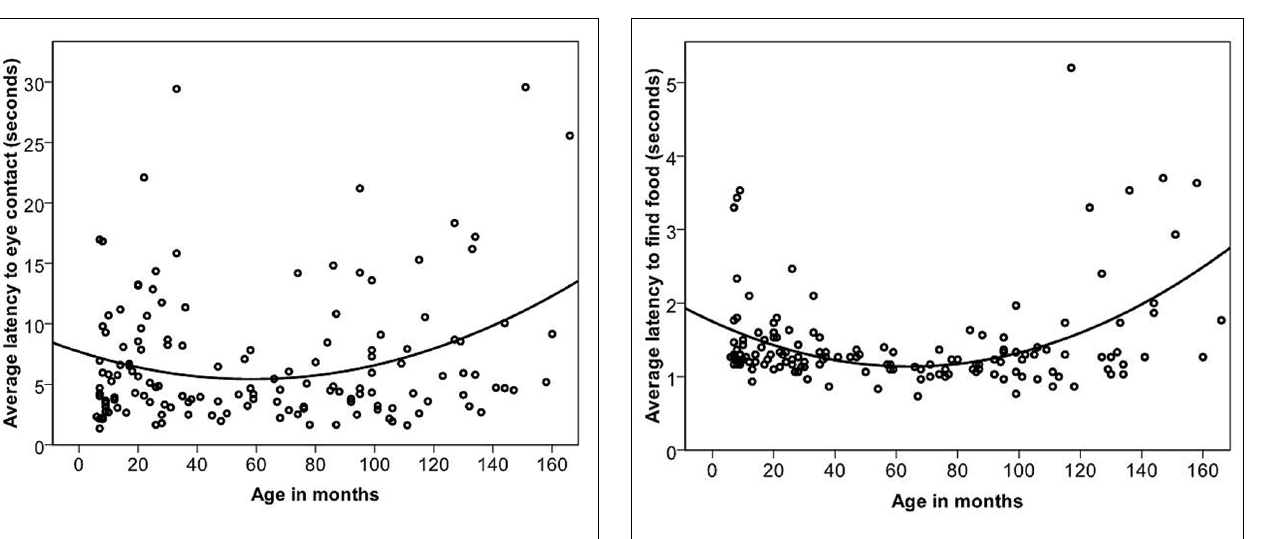
Learning across trials